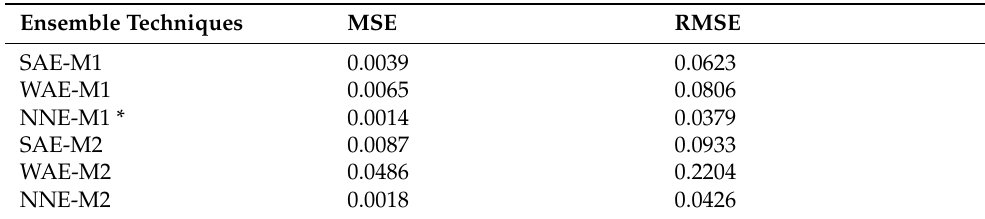
Figure 8. Boxplot for M1 and M2 in the validation phase for TDS. Table 3. Ensemble results of SA-E, WA-E, and NN-E for TDS.